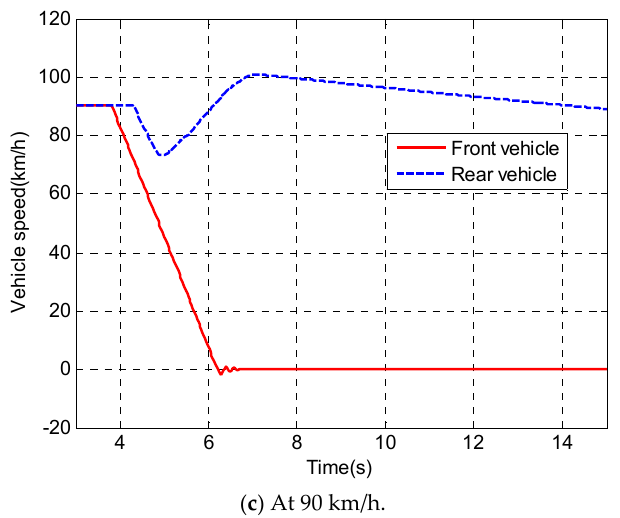
Figure 9. Velocity profile of the steering. Appl. Sci. 2016 , 6 , 327